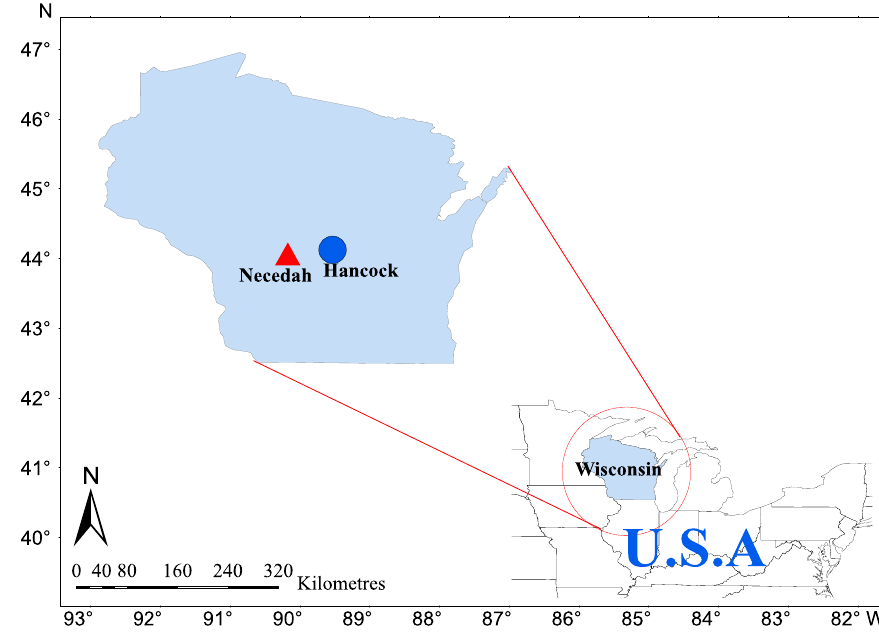
Figure 1. Location of the Hancock station and of the Necedah (44°1 ′ 34 ″ N/90°4 ′ 26 ″ W) CRN station used to evaluate the quality of the solar radiation time series at Hancock (44°8’1 ″ N/89°31’23 ″